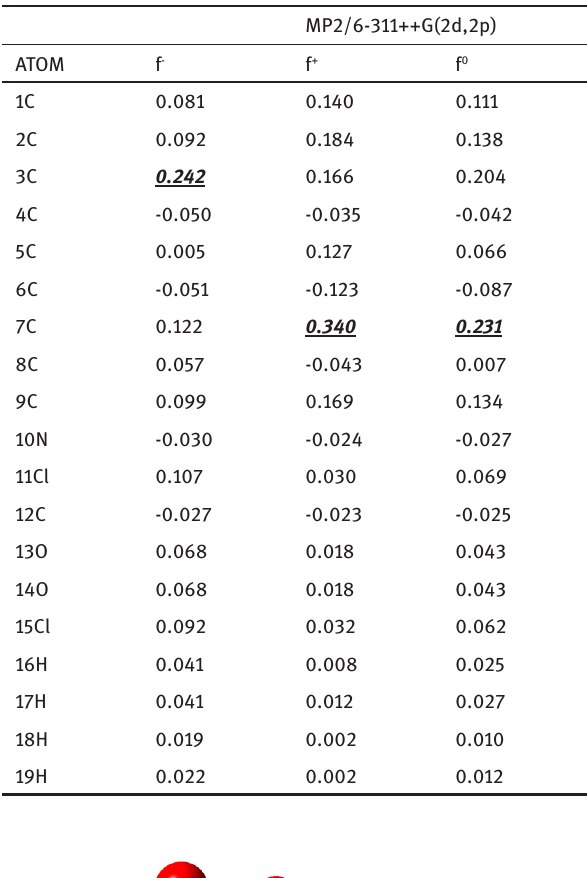
Table 5: Values of the condensed Fukui function in deprotonated quinclorac computed from NBO charges according to Eqs. 9, 11, 12 in aqueous phase.